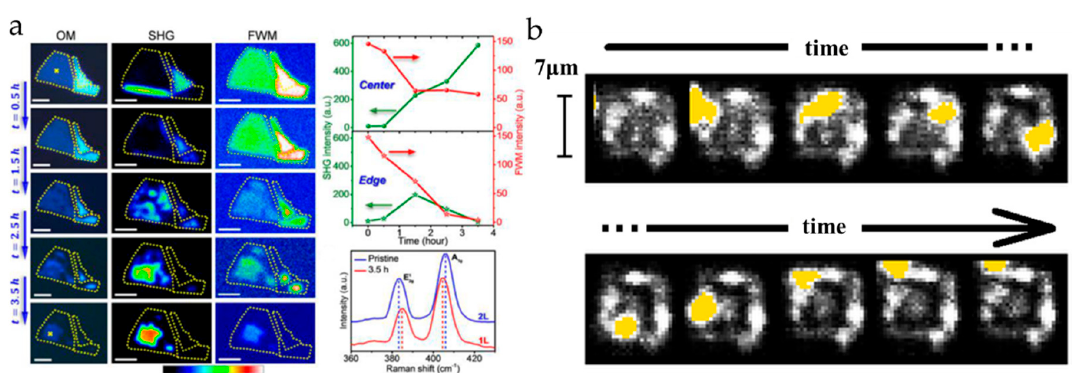
Figure 12. ( a ) Variation of optical, SHG, FWM images of the thermal oxidation process of an MoS 2 sheet with different heating times. Reproduced from [17], with permission from American Chemical Society, 2016. ( b ) Time-varying image of the FWM signal of photo-oxidation graphene, where yellow is the oxidized laser beam and white is the FWM signal. Reproduced from [100], with permission from AIP Publishing, 2016.